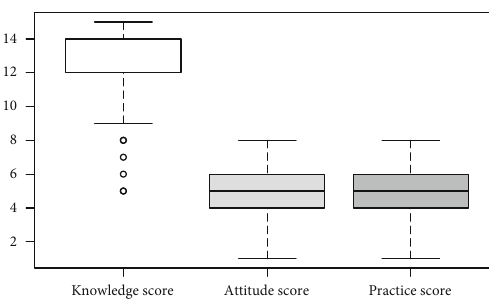
Figure 2: Boxplot of total knowledge, attitude, and practice